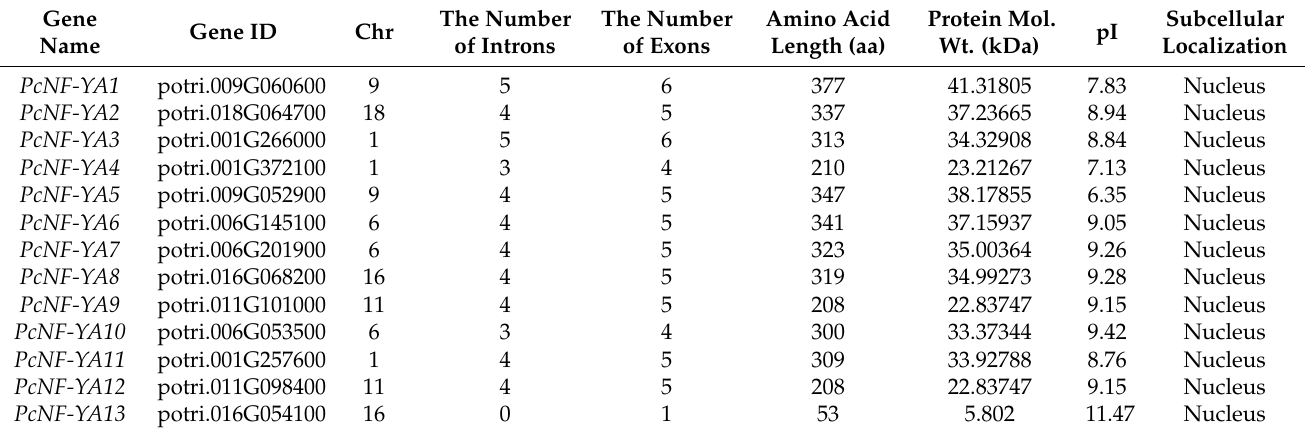
Table 1. NF-YA genes identified in P. × canescens